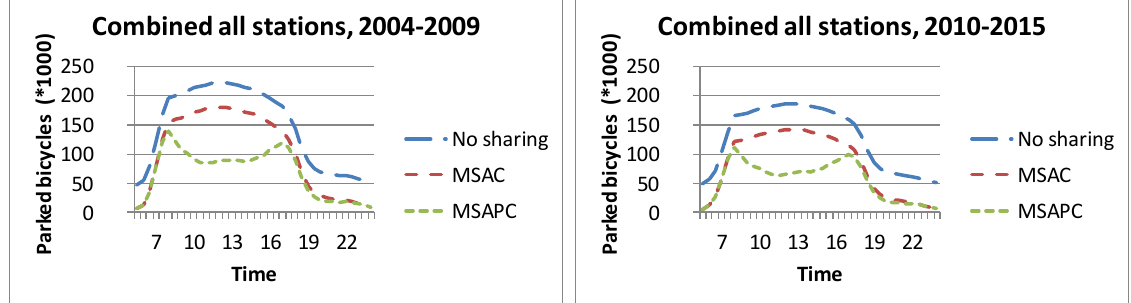
Figure 8. Distribution of parked bicycles over time for different sharing cases, whole